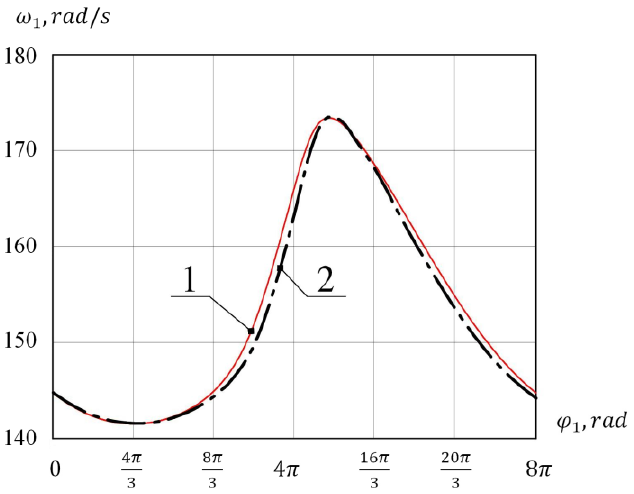
Figure 9. Graphs of function ω 1 ( ϕ 1 ) without flywheel: 1—the energy-mass method, 2—the third-order Hermite interpolation function.